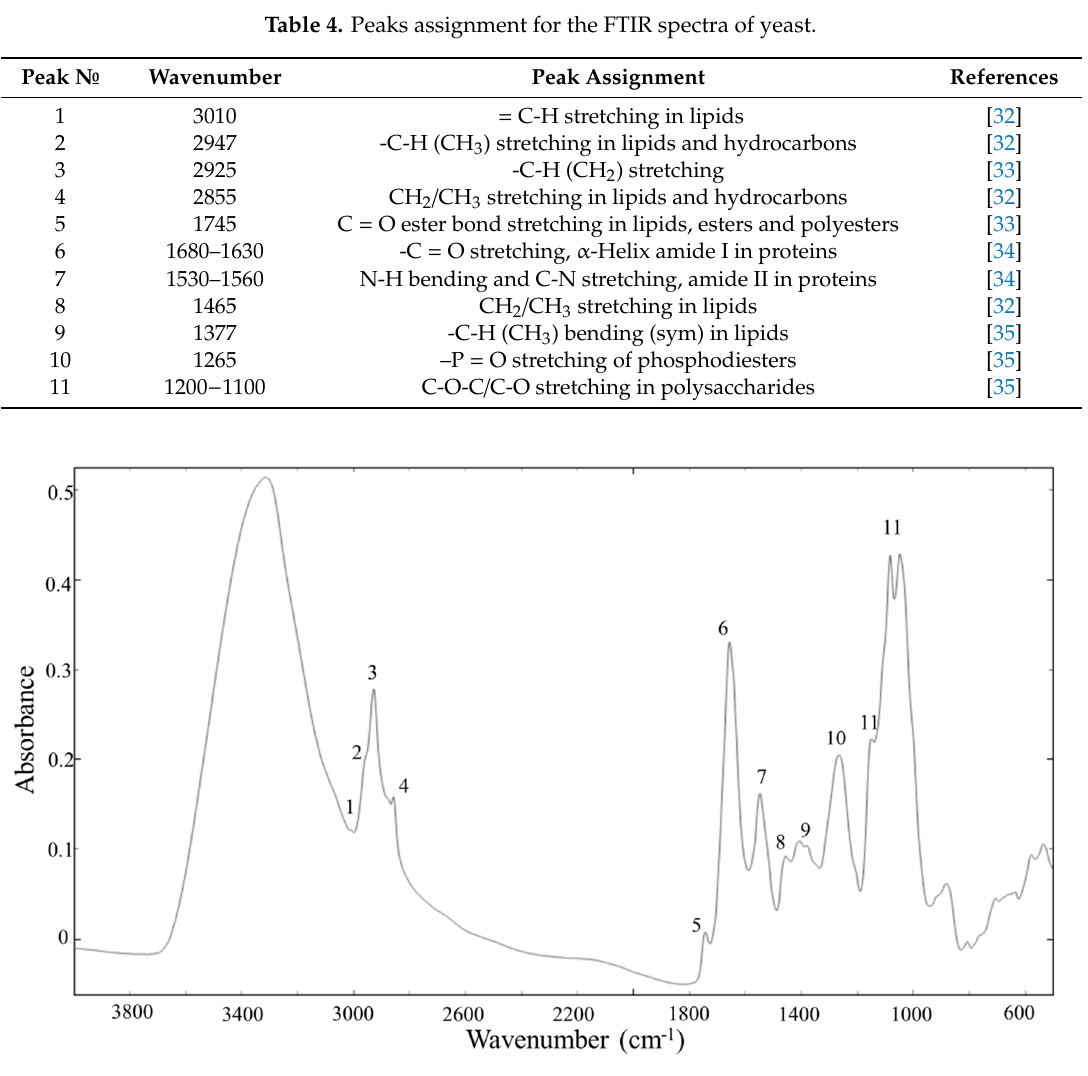
Figure 4. Preprocessed FTIR spectra S. cerevisiae CCY 21-4-102 biomass grown in the C / N ratio 70:1. Peak numbers correspond to the numbers given in Table 4.